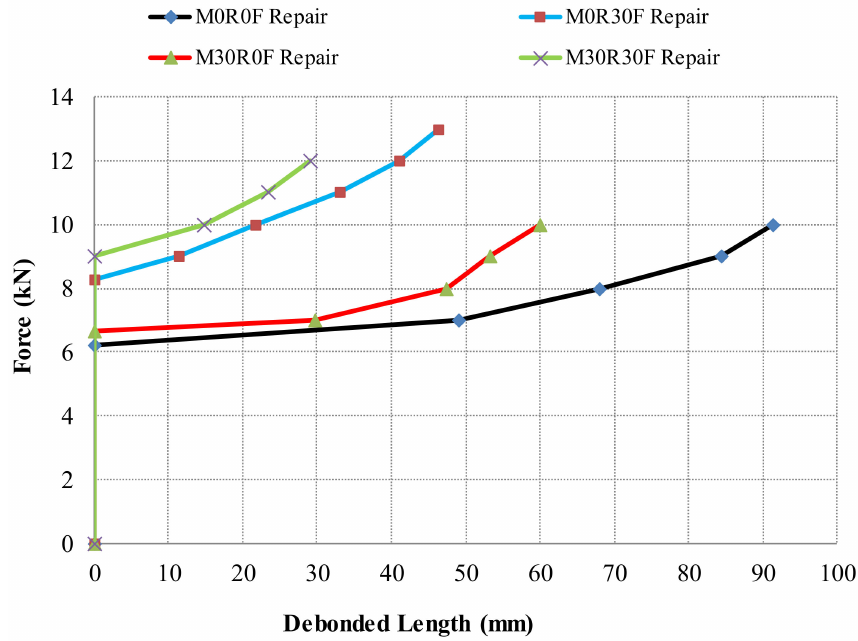
Figure 19. Force versus debonded length for various repair